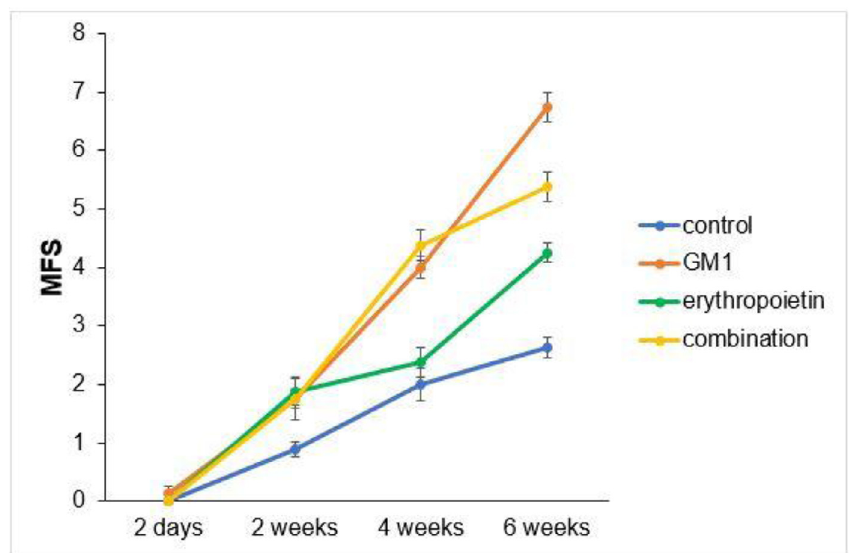
Fig. 2. MFS scale mean pro fi les per group and respec- tive standard